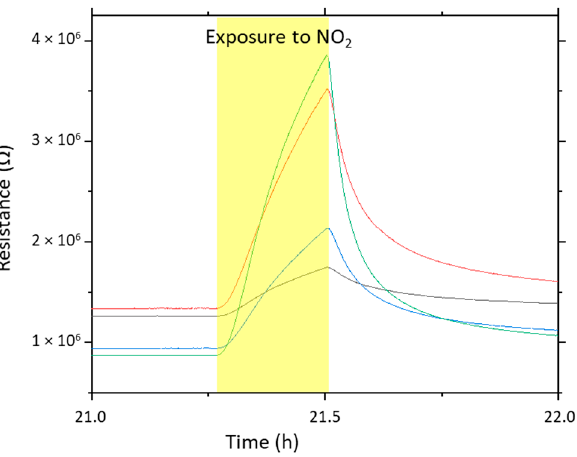
Figure A4. Typical electrical resistance evolution of DLow devices when exposed to dioxide nitride (0.1 ppm) at 370 °C.